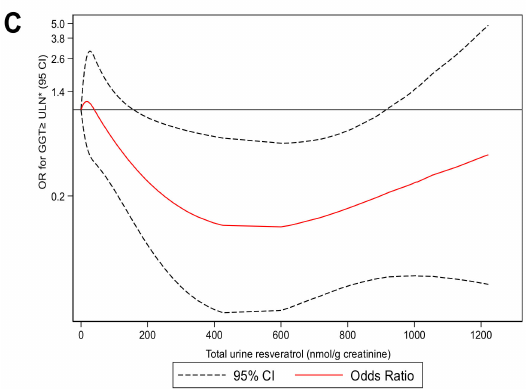
Figure 1. The odds ratio for liver enzymes levels above the upper limit of normal (ULN) for total urine resveratrol concentration in nmol / g creatinine. ULN range for ALT (men ≥ 30 UI / L, women ≥ 19 UI / L) ( A ), AST (men ≥ 37 UI / L, women ≥ 31 UI / L) ( B ), and GGT (men ≥ 60 UI / L, women ≥ 40 UI / L) ( C ). The smooth line represents the estimation of higher ALT, AST, and GGT levels when using zero as the reference value for total urine resveratrol metabolite (4 knots for ALT and GGT; 3 knots for AST) whereas the dashed lines indicate 95%